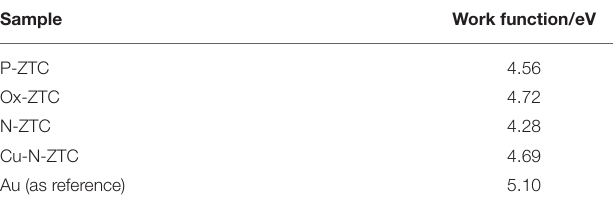
TABLE 3 | Work function of ZTC samples.